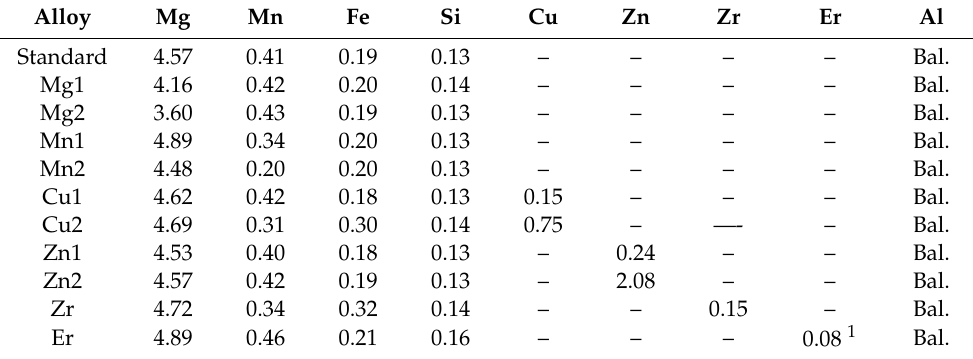
1 Er content measured via